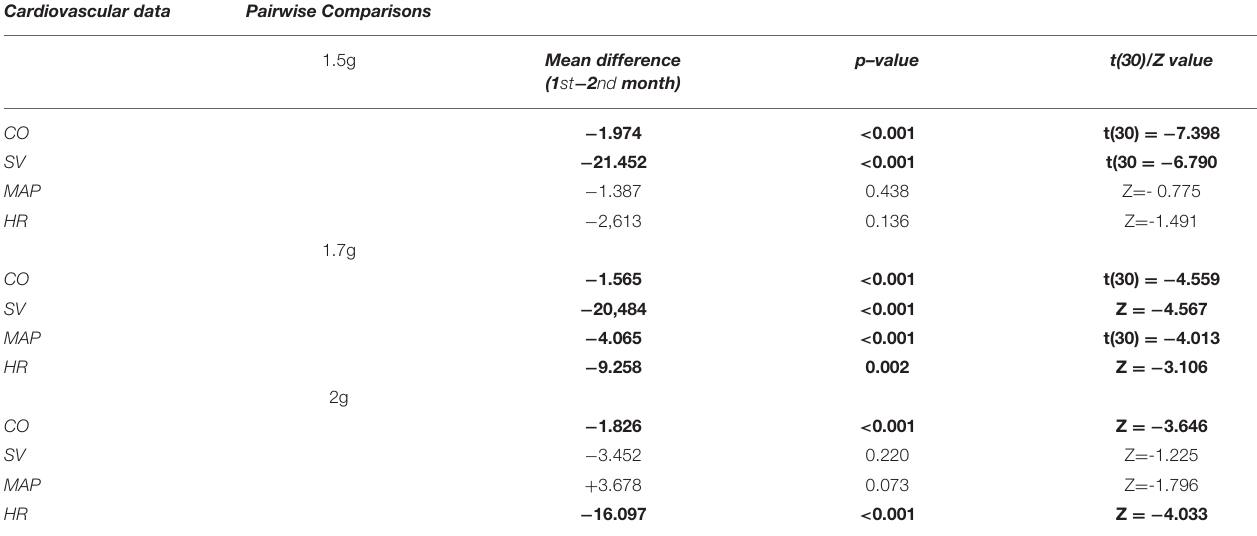
TABLE 1 | Description of the pairwise comparisons at 1st and 2nd period regarding cardiovascular features across 1.5, 1.7, and 2g respectively. Cardiovascular